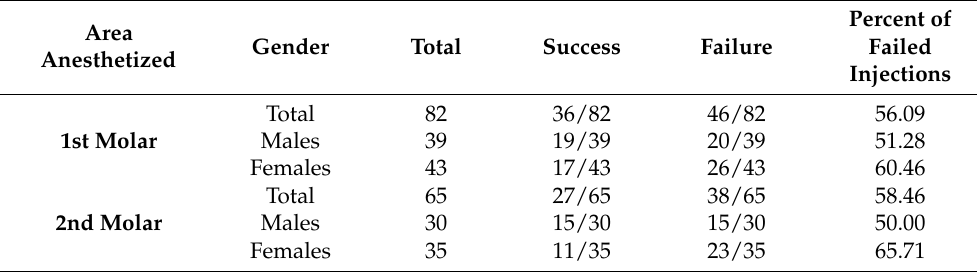
Table 1. Gender-wise distribution of failed primary inferior alveolar nerve block anesthesia in symptomatic irreversible pulpitis patients.